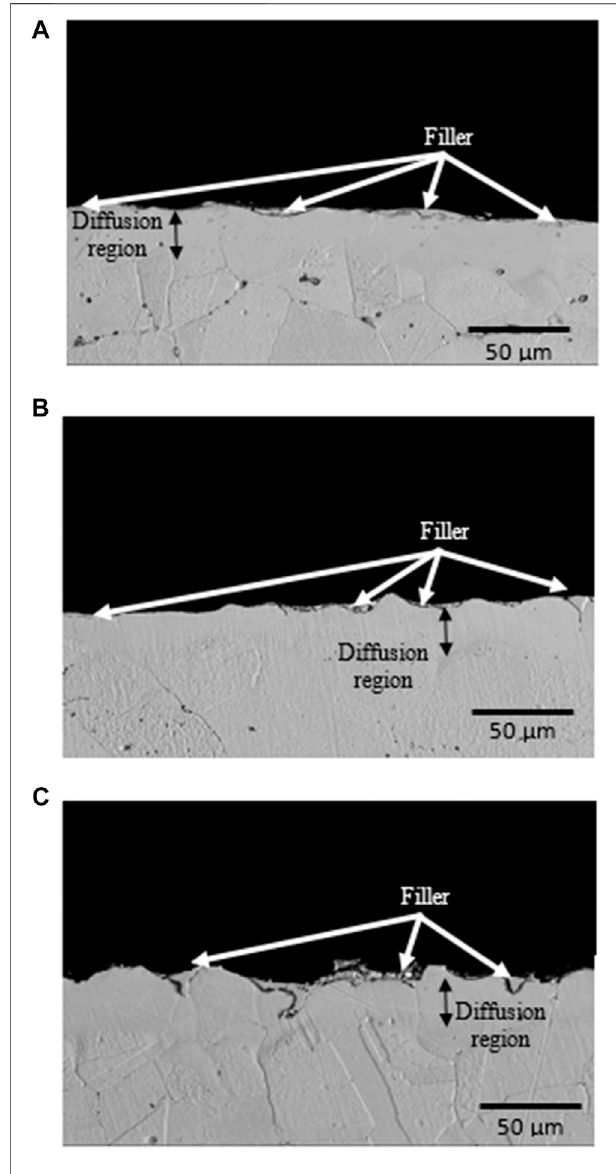
FIGURE 7 | Shear fracture of side-view Cu substrate surface from the brazed Cu/Cu foam shear test with different Cu foam pore densities of (A) foam A, (B) foam B, and (C) foam